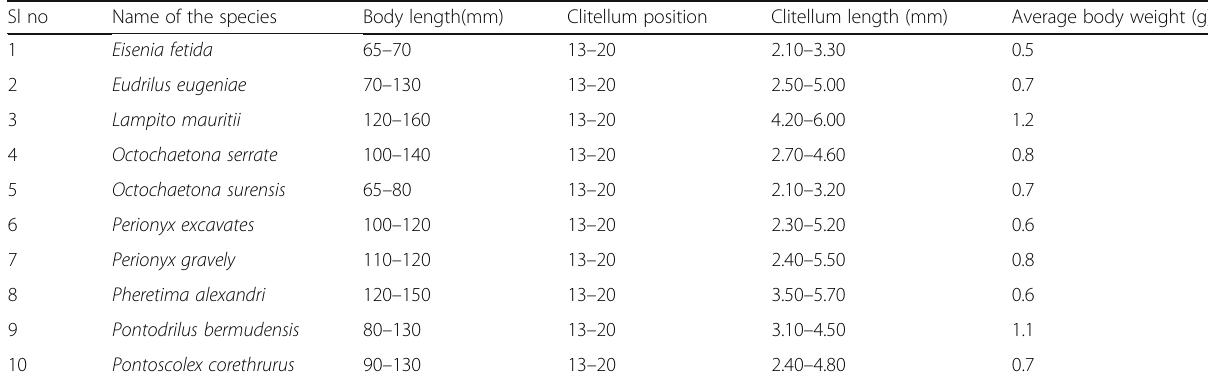
Table 2 Morphological characteristics of earthworm populations collected